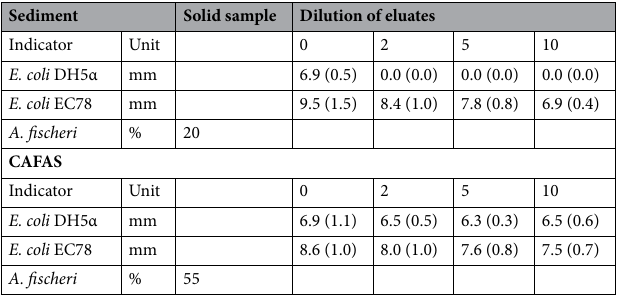
Table 5. Assessing toxicity of solid samples based on A. fischeri and eluates based on E. coli indicator systems. Data for E. coli toxicology assay are mean (standard